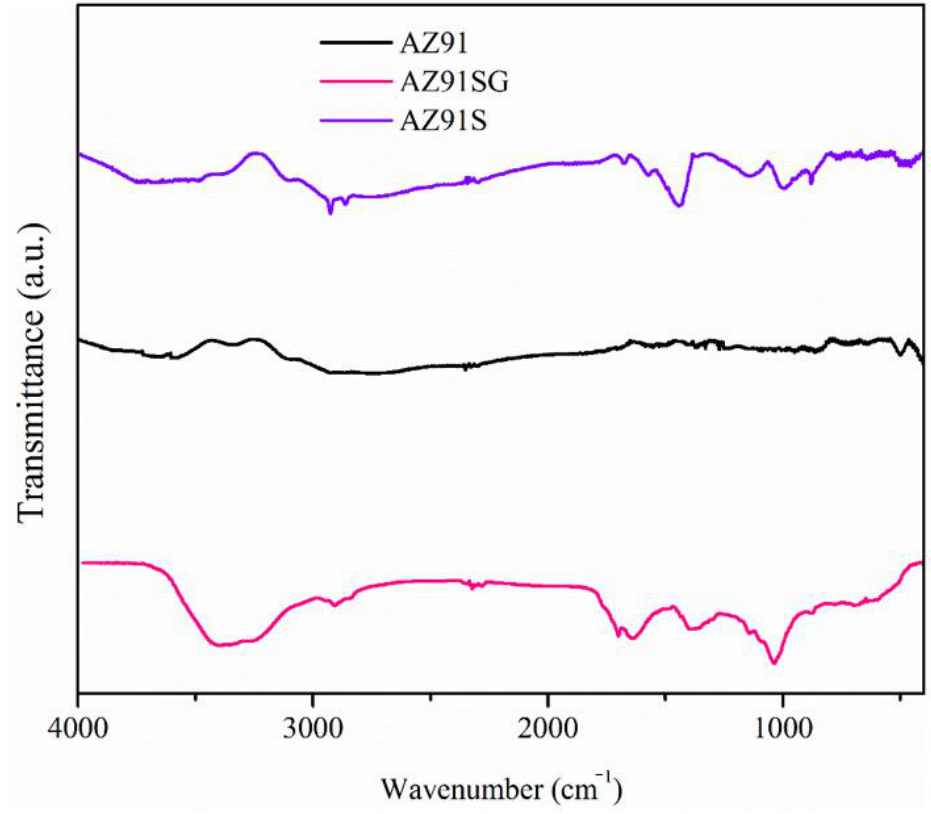
Figure 2. FTIR spectra for AZ91SG with AZ91 and AZ91S as the control groups.